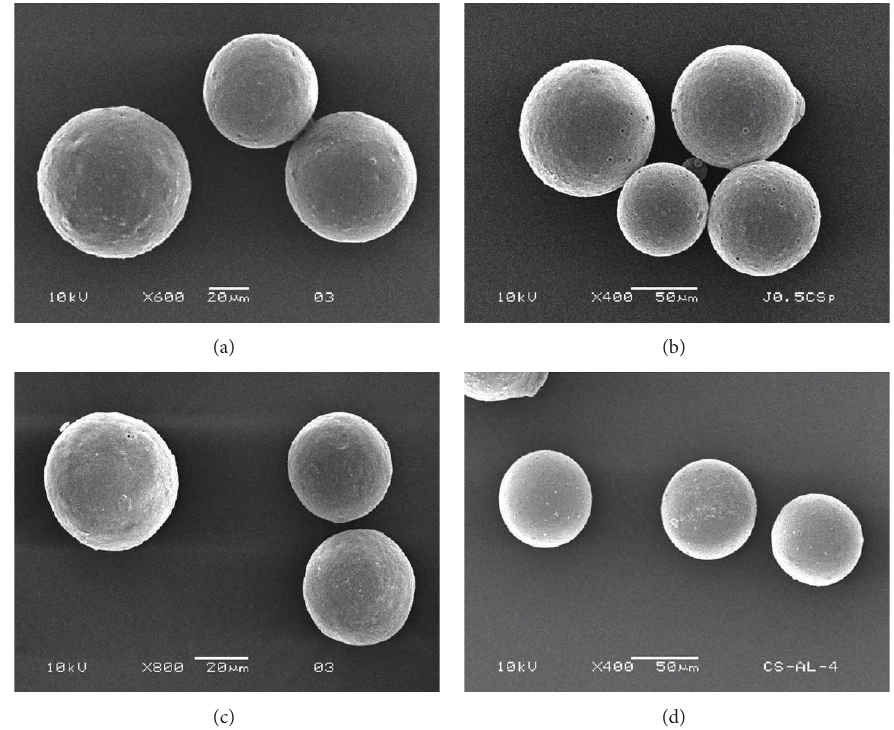
Figure 4: SEM images of drug-loaded microspheres of (a) 15kDa chitosan, (b) 100kDa chitosan, (c) potato starch, and (d) alginate. Bars = 20 𝜇 m for (a) and (c), and 50 𝜇 m for (b) and (d).